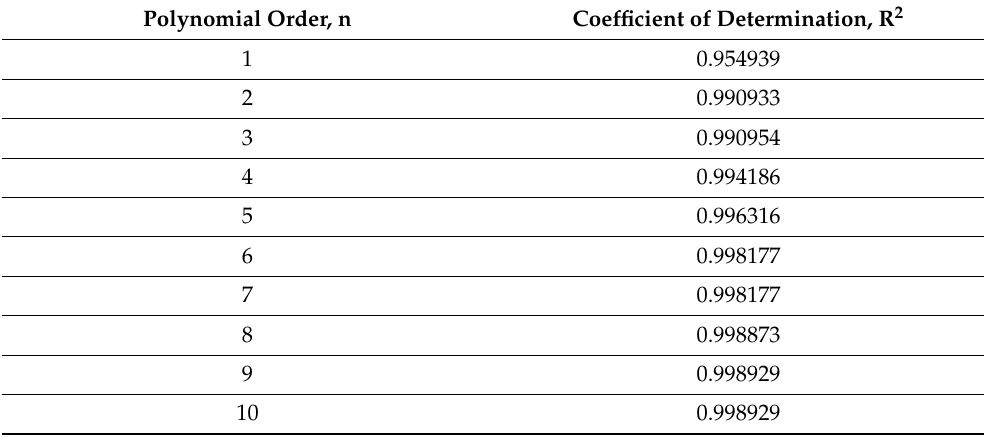
Table A2. The relationship between the polynomial order and the coefficient of determination.